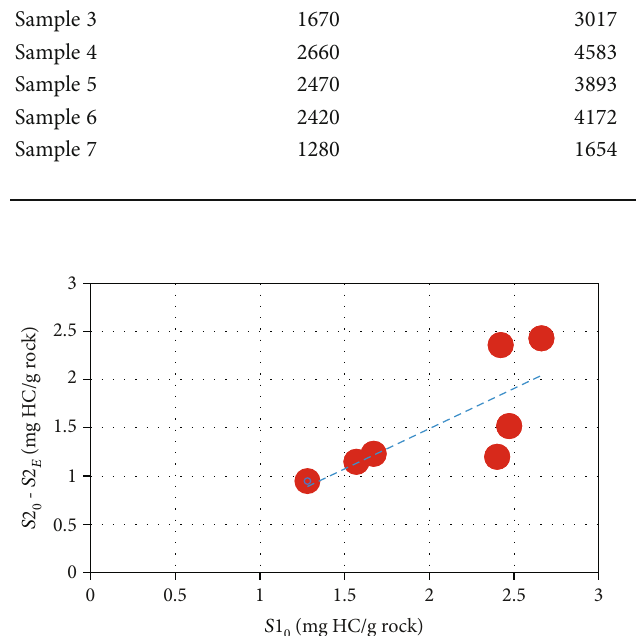
Figure 7: Correlation graph of the amount of heavier liquid hydrocarbons ( Δ S 2 ) versus S 1 0 parameter obtained by Rock Eval pyrolysis of the samples not subjected to solvent extraction; a signi fi cant convergence is observed with a correlation coe ffi cient equal to